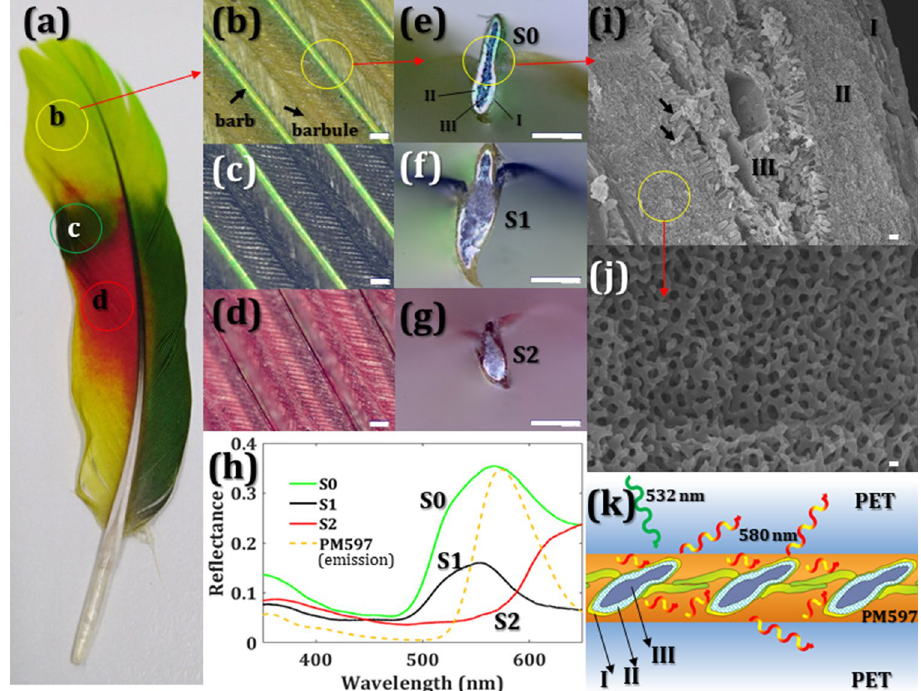
Figure 1. Turquoise-Fronted Amazon feather for random lasing. ( a ) The photo of a Turquoise-Fronted Amazon feather. ( b )–( d ) The images of yellow-green S0, dark-green S1, and red S2 feathers were zoomed in from circles b,c, and d in ( a ). ( e )–( g ) The cross-section views of ( b )–( d ). ( i ) The SEM image of ( e ), from I to III are the outer cortex, photonic crystals, and porous cells. The black arrow indicates the pigment. ( j ) The SEM image of photonic crystals. ( k ) Schematic illustration of the random laser sandwiched by two plastic layers. The scale bars are 100 μm in ( b )–( g ), 1 μm in ( i ), and 100 nm in ( j